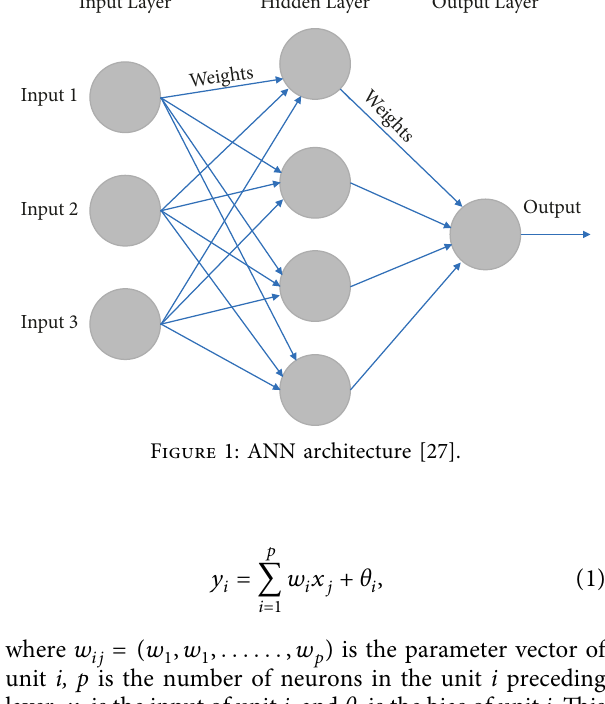
Figure 1: ANN architecture